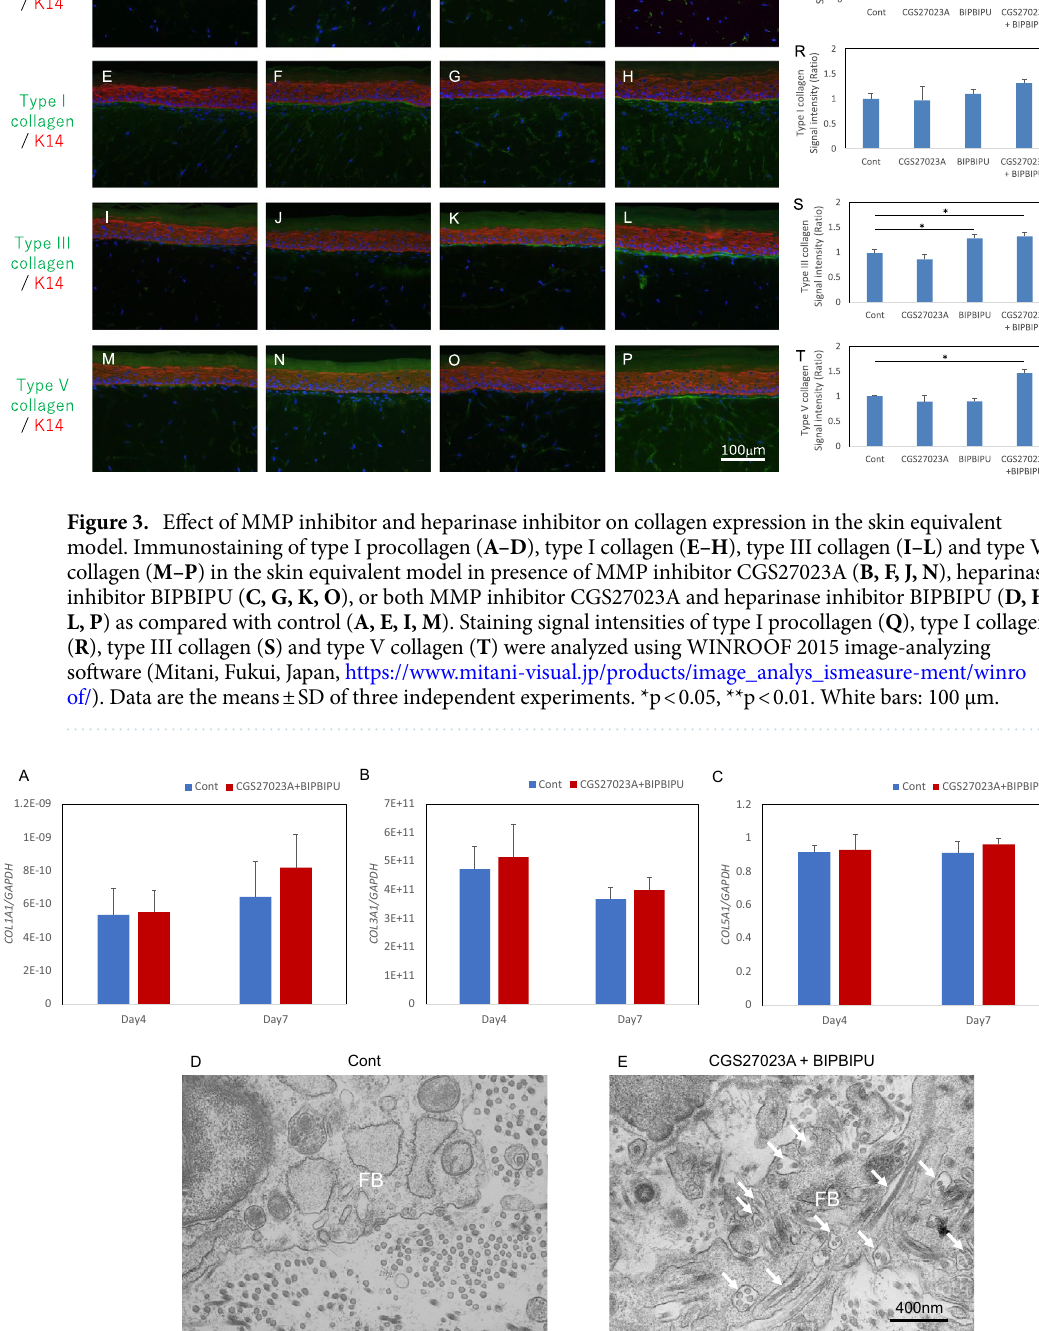
Figure 4. Effect of MMP inhibitor and heparinase inhibitor on the accumulation of collagen fibrils in the skin equivalent model. mRNA expression levels of the COL1A1 ( A ), COL3A1 ( B ) and COL5A1 ( C ) genes were analyzed by qPCR. Data are expressed as mean ± SD of three independent experiments. The ultrastructure of collagen fibrils at the papillary dermis was imaged by transmission electron microscopy in the skin equivalent model in presence of MMP inhibitor CGS27023A and heparinase inhibitor BIPBIPU ( E ) as compared with control ( D ). Representative TEM images from three independent experiments are shown. FB: Fibroblasts. White arrow: collagen fibrils in fibroblasts. Black bar: 400